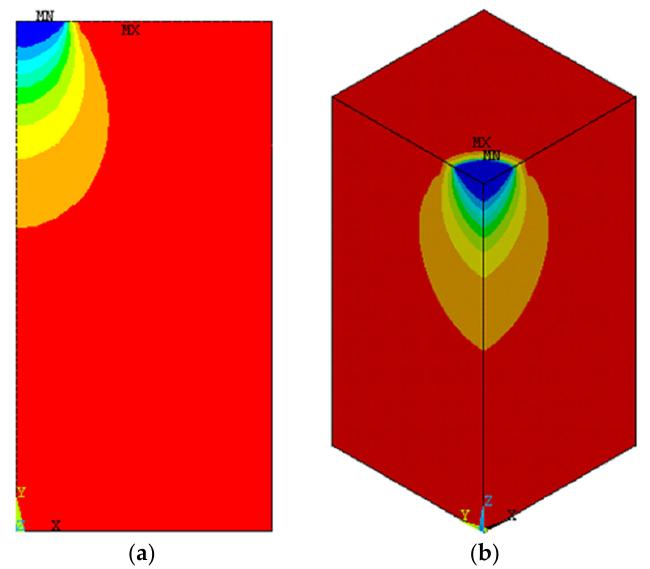
Figure 22. Vertical stresses beneath the 150 mm circular footing: ( a ) 2DM; ( b ) 3DM.